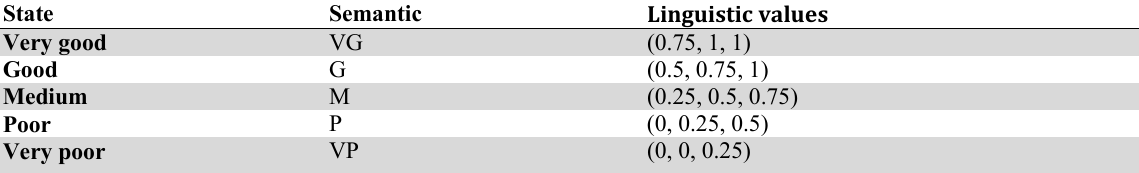
Qualitative negotiation issue